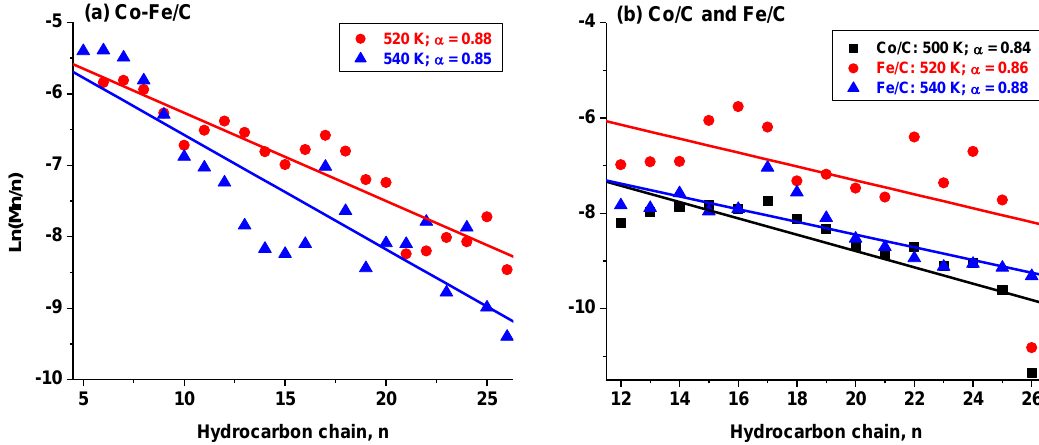
Figure 9. Modelling ASF kinetics using selectivity data of the ( a ) Co-Fe/C and ( b ) single-metal Co/C sample tested at 500 K, and the Fe/C sample tested at 520 K and 540 K.